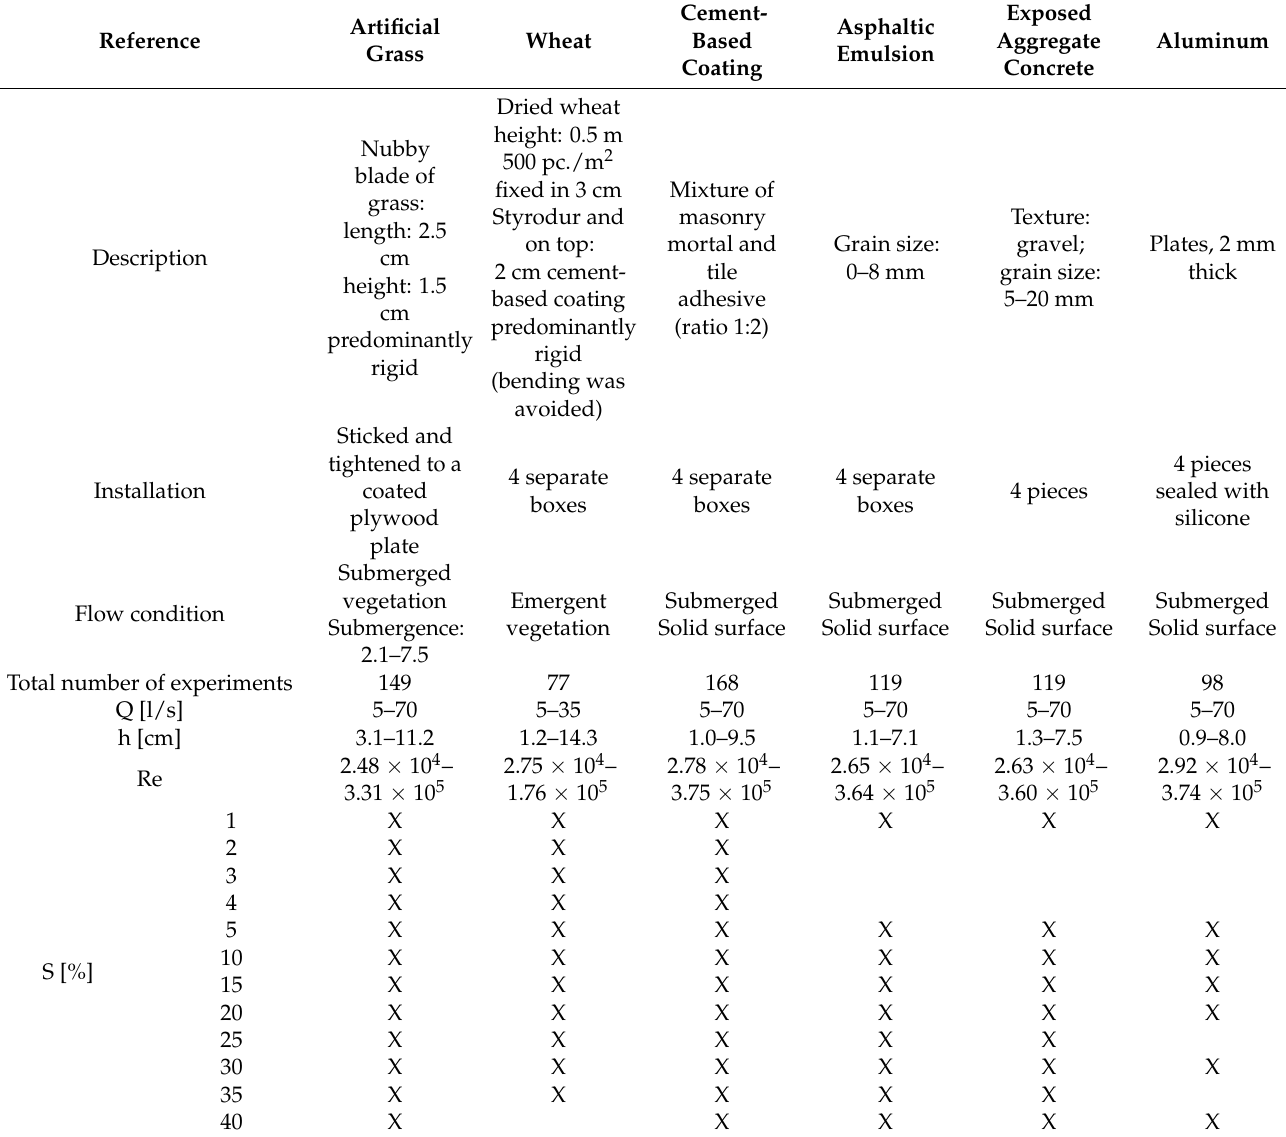
Table 1. Experimental